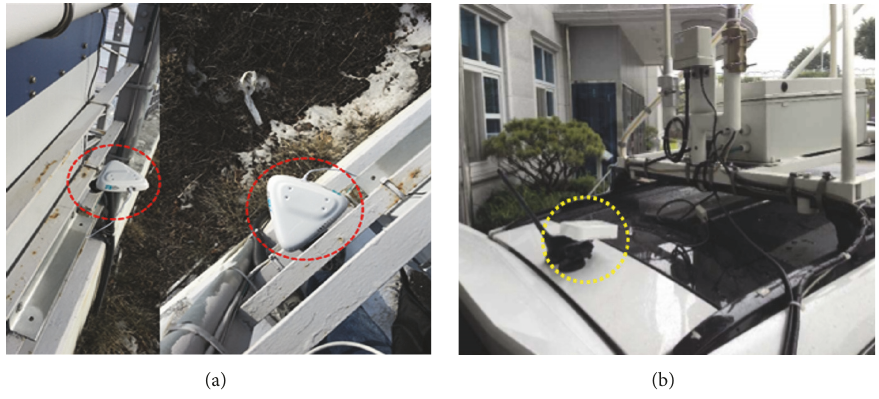
Figure 2: Installation of the Mini-AWS in cross-country stadium (a) and on a mobile vehicle (b).